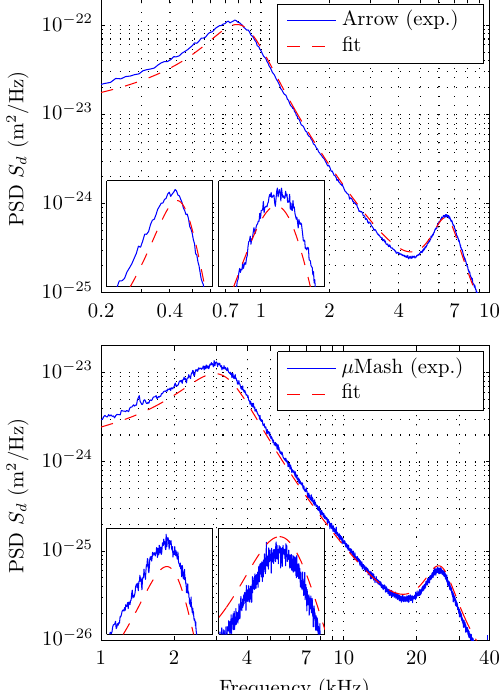
Figure 5. Comparisons of the quality of the fits of the PSDs for both cantilevers used. ( Top ) The Arrow TL1, NanoWorld cantilever produces an optimized fit that has a notorious mismatch in the resonances frequencies. Insets: details of the fits for the first and the second cantilever resonance; ( Bottom ) Same as the top curve for the MikroMasch (HQ:CSC38) cantilever. Insets: the fit with the Sader’s model captures both resonances